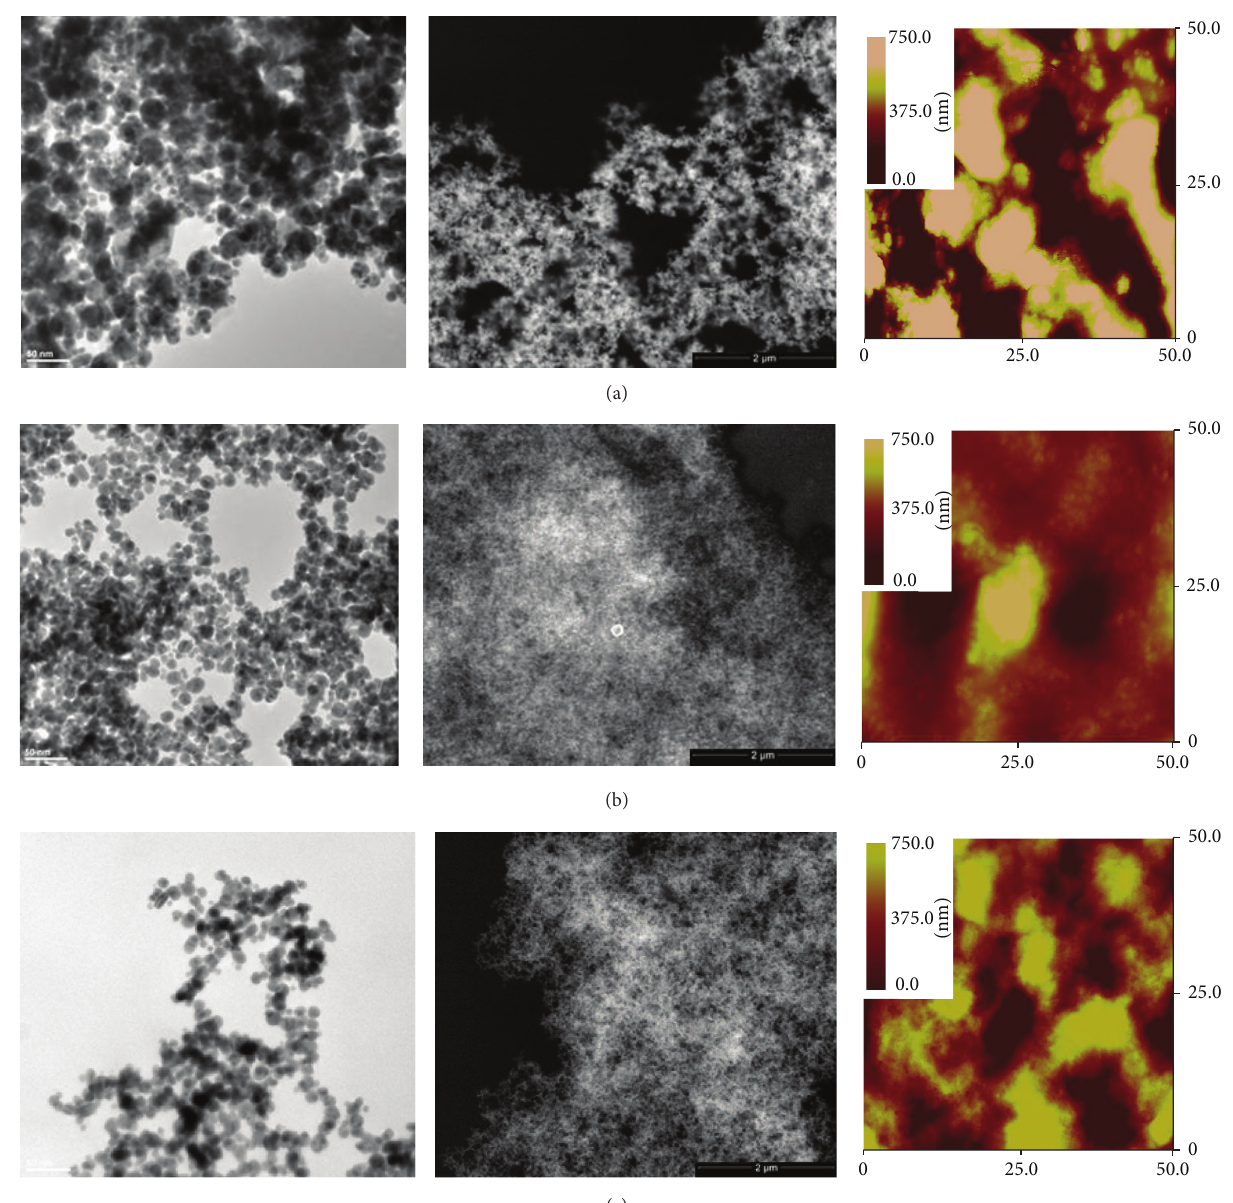
Figure 5: Morphology evaluation through TEM, SEM (50000x), and AFM (50 𝜇 m × 50 𝜇 m) of samples (a): Au-G2-5, (b): Au-G4-5, and (c): Au-G6-5 after two weeks after synthesis. Spherical particles are visible in TEM, with dimensions decreasing with the increasing generation of dendrimer. SEM reveals porous networks consisting in self-assembled nanoparticles. Nanostructured chains are entangled and delimitate internal pores. AFM confirms the results from TEM and